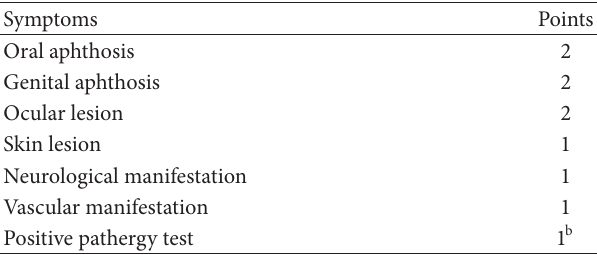
Table 4: International Criteria for Behcet’s Disease